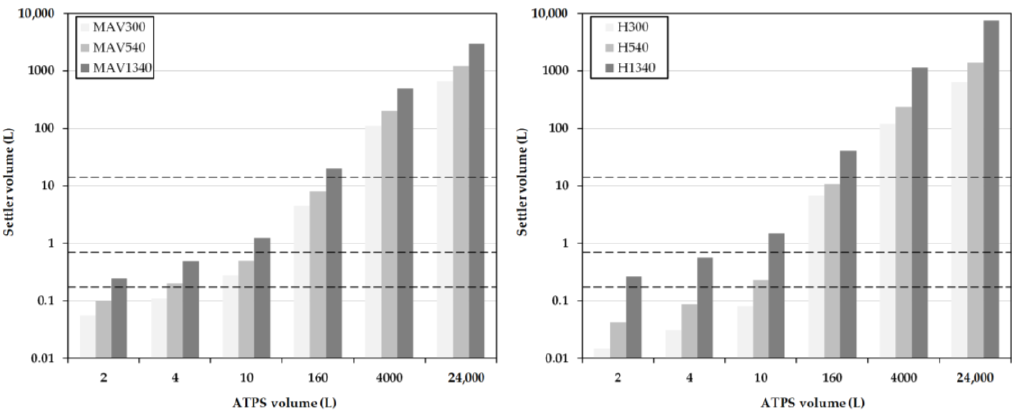
Figure 16. Settler volume as a function of residence time for different system scales obtained for the